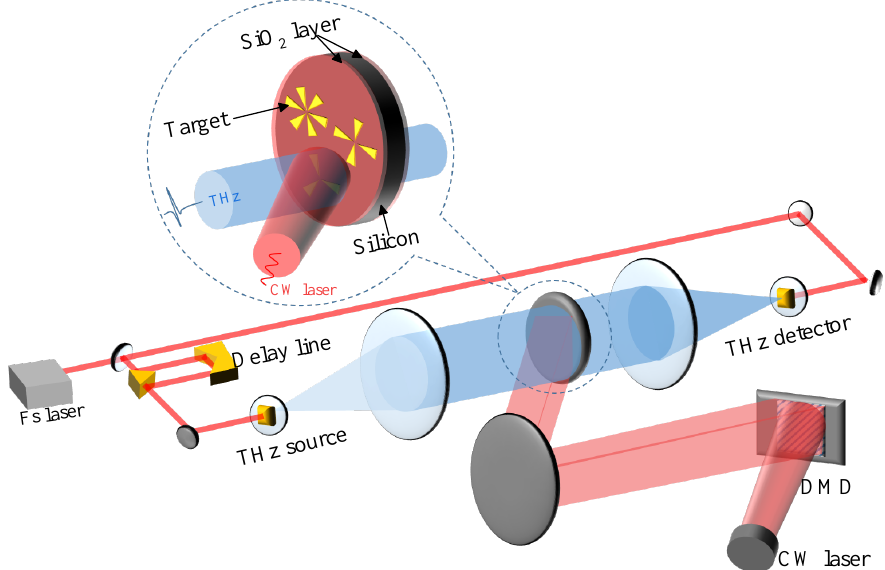
Figure 1. Schematic of the experimental setup for the THz single-pixel imaging. The CW laser is reflected on the modulator by DMD, and target objects are cartwheels patterned in gold film, which is deposited on the modulator